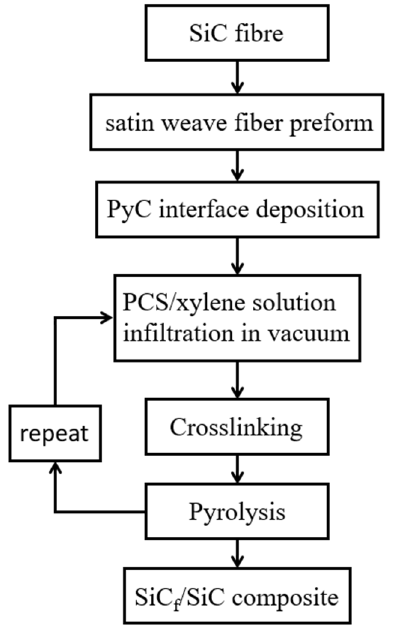
Figure 2. The flow chart of the composite preparation.